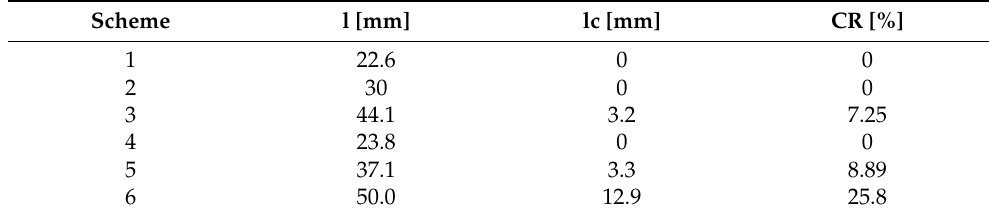
Table 4. Results of the compaction ratio.